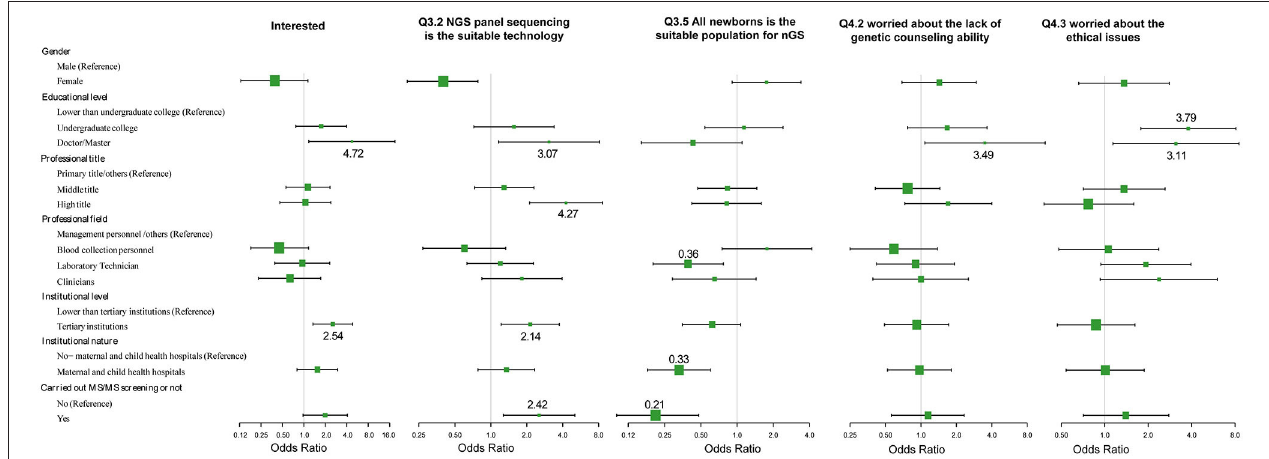
FIGURE 4 | Association between demographic characteristics and attitudes and knowledge toward